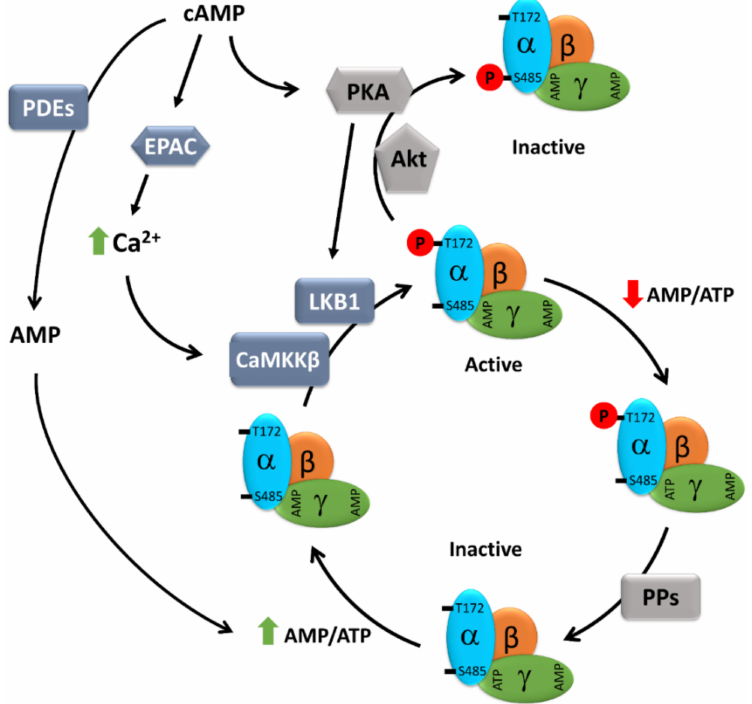
Figure 1. Schematic presentation of the cAMP-dependent regulation of AMPK activity. AMPK consists of three subunits: one catalytic subunit alpha and two regulatory subunits, beta and gamma. At a high AMP/ATP ratio, ATP bound to the γ -subunit is exchanged for AMP, causing an allosteric modification of AMPK that leads to reduced access of Thr172 to phosphatases, but easy access to LKB1 and CaMKK β , resulting in enhanced AMPK phosphorylation and activation. cAMP, either via EPAC-dependent activation of CaMKK2 or PKA-dependent activation of LKB1, may promote AMPK activity. On the other hand, both PKA and Akt can also directly phosphorylate AMPK at inhibitory Ser485, thus negatively regulating its activity. Furthermore, cAMP elevation may lead to the simultaneous elevation of AMP, a degradation product of cAMP resulting from PDE activity, which, via an increasing AMP/ATP ratio, may promote AMPK activity. AMP: adenosine monophosphate; ATP: adenosine 5’-triphosphate; cAMP: cyclic AMP; CaMKK β : Ca 2+ /calmodulin regulated kinase kinase beta; EPAC: exchange protein directly activated by cAMP; LKB1: liver kinase b1; PDEs: phosphodiesterases; PKA: protein kinase A; PPs: protein